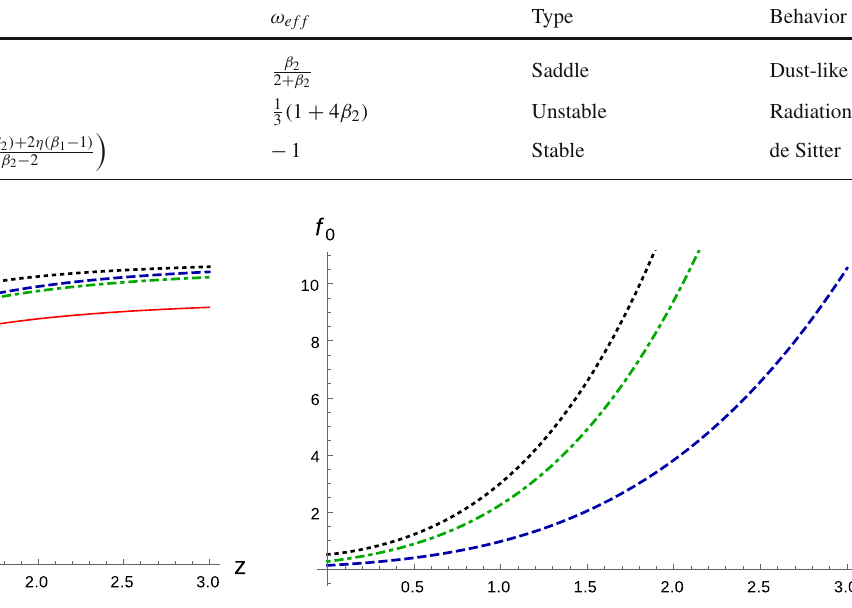
Fig. 2 The evolution of the matter density abundance as a function of the redshift z for three different values for the constant η = − 0 . 02 (dot-dashed), η = 0 (dashed) and η = 0 . 1 (dotted). We use the best fit values for the model parameters presented in Table 2. The (cid:2) CDM curve is depicted as a red curve abundance (cid:14) m , defined as